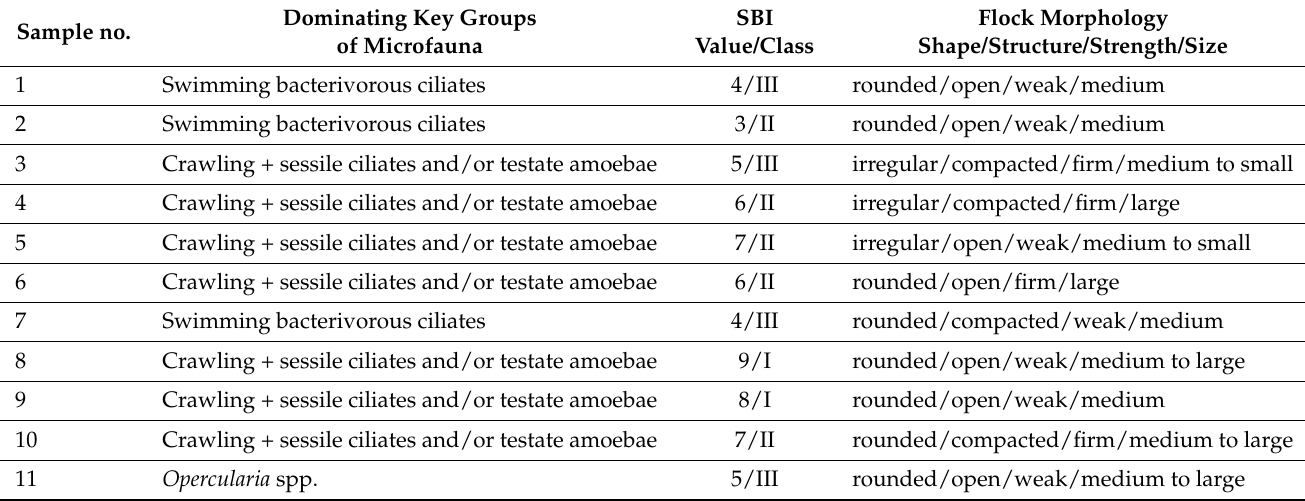
Table 7. Results of microscopic analyses of activated